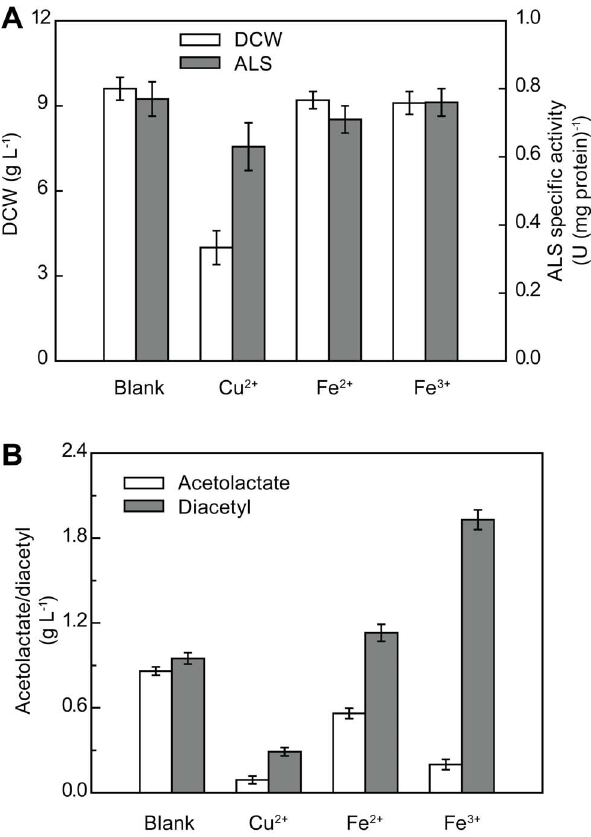
Figure 5. Characteristics of the engineered strain DA-3 in medium containing Cu 2 + , Fe 2 + , and Fe 3 + . (A) Effects of metal ions on cell growth and ALS activity. (B) The ability of metal ions to transform a -acetolactate to diacetyl in the fermentation process. The present data were obtained after optimizing the titers of the metal ions added with respect to diacetyl production and cell growth.